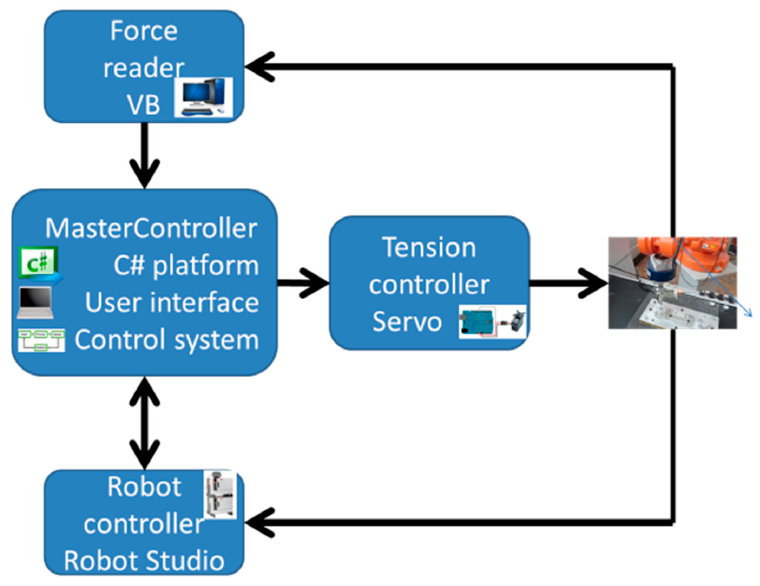
Figure 9. ( a ) Automatic fiber tensioning tool; ( b ) Real system implementation.